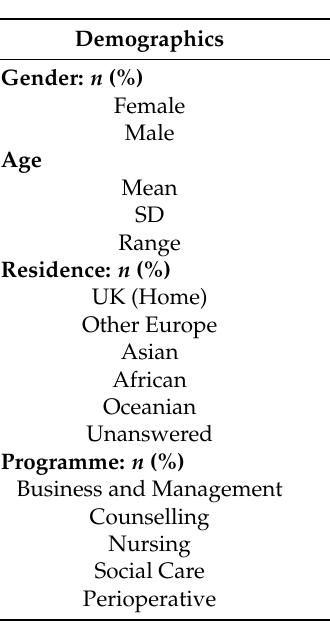
Table 1. Demographic data of